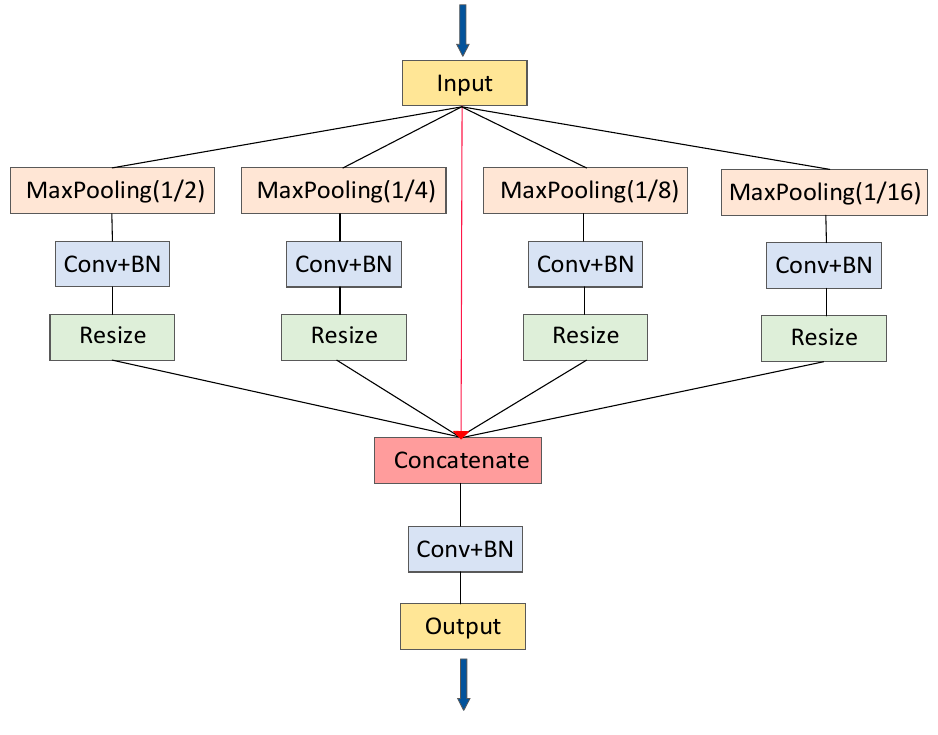
Figure 4. Structure of the PSP pooling module.